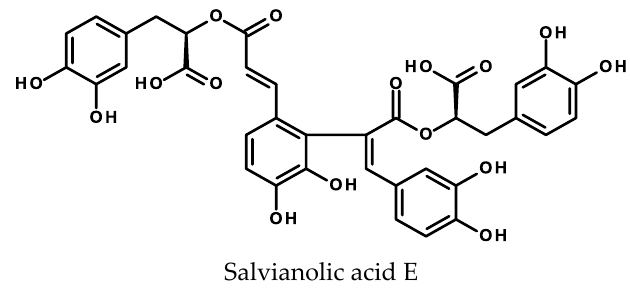
Figure 5. Chemical structures of rosmarinic acid and selected salvianolic acids.